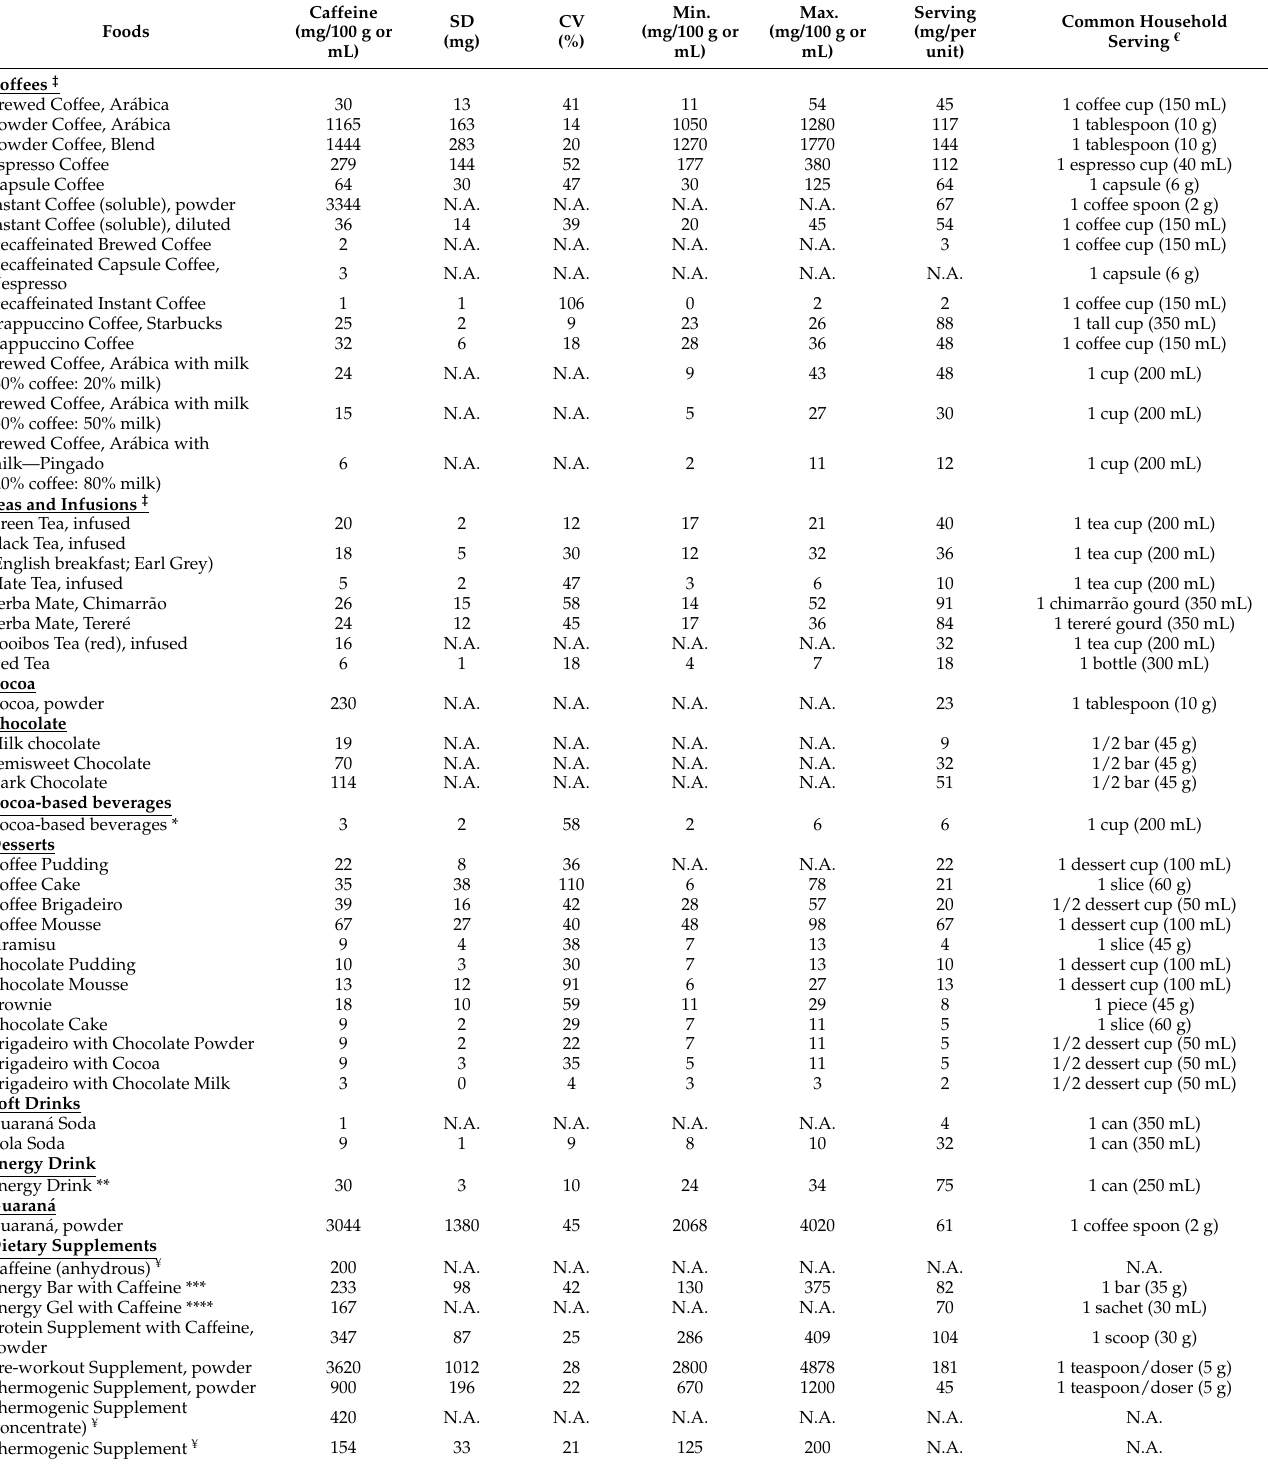
Table 1. Brazilian caffeine content table